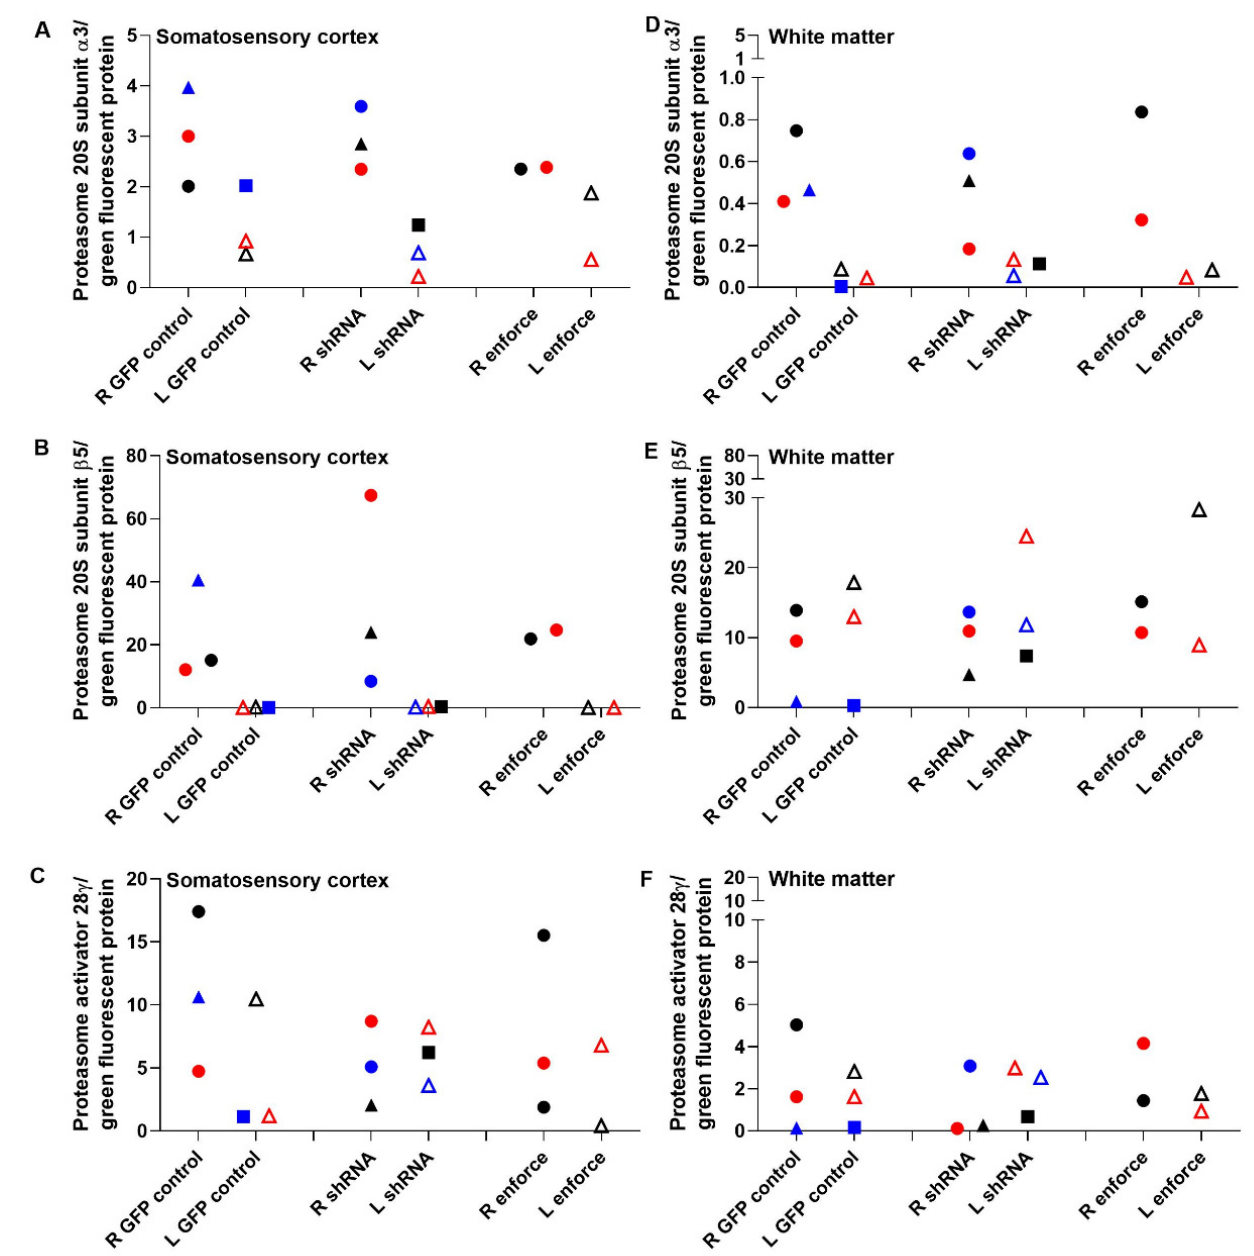
Figure 11. Western blot data for proteasome 20S subunits in piglets that received intracerebral adeno-associated virus (AAV)-green fluorescent protein (GFP), AAV-shRNA to PA28 γ -GFP, or AAV-PA28 γ -GFP and sham procedure with hypothermia. Data are normalized to (divided by) the piglet’s GFP level as a measure of AAV transduction in the right (R) and left (L) somatosensory cortex ( A – C ) and subcortical white matter ( D – F ). AAV-shRNA to PA28 γ -GFP did not consistently decrease PA28 γ levels or alter the levels of α 3 and β 5 subunits compared to AAV-GFP. AAV-PA28 γ -GFP did not reliably raise the subunit levels. Data points from the same piglet are matched by color within each treatment group. The shapes indicate the AAV dose in each cerebral hemisphere: square = 2 × 10 10 –2 × 10 11 genome copies (gc), circle = 4 × 10 10 –4 × 10 11 gc, and triangle = 5 × 10 10 –5 × 10 11 gc. Open symbols indicate piglets that also received adjuvant (40 ng of F108 and 2.5 µ g of polybrene). Data were divided by a Ponceau-stained protein loading